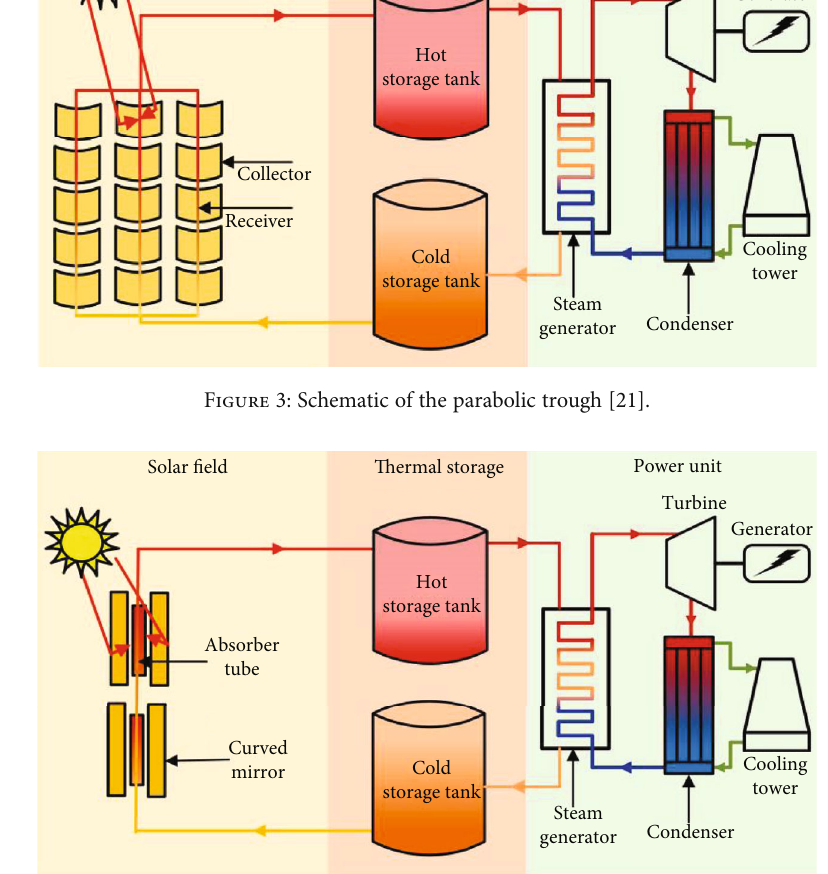
Figure 4: Illustration of a linear Fresnel re fl ector (LFR) system [21].